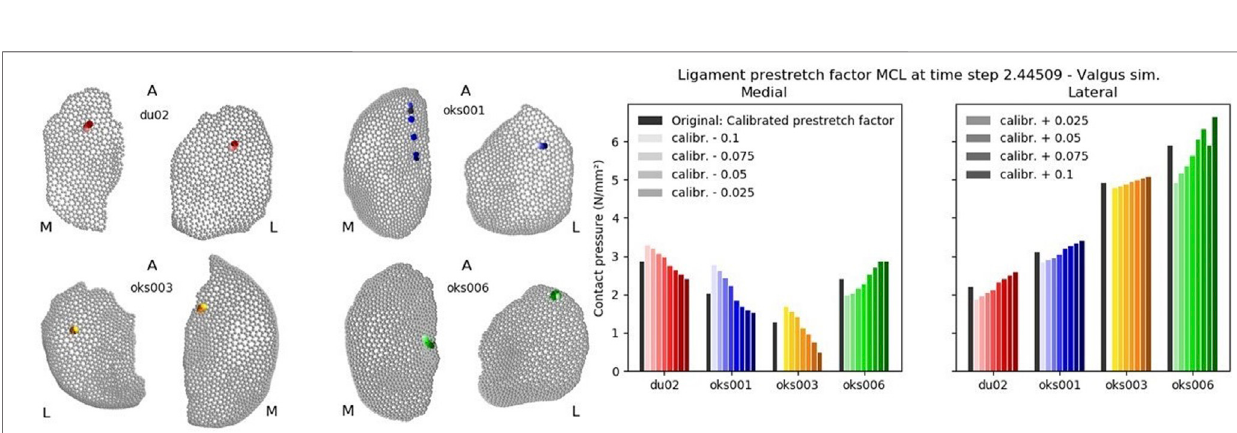
FIGURE 4 | Convergence (left) and valgus kinematics (right) results for all valgus simulations of the Ligament prestretch factor MCL parameter.